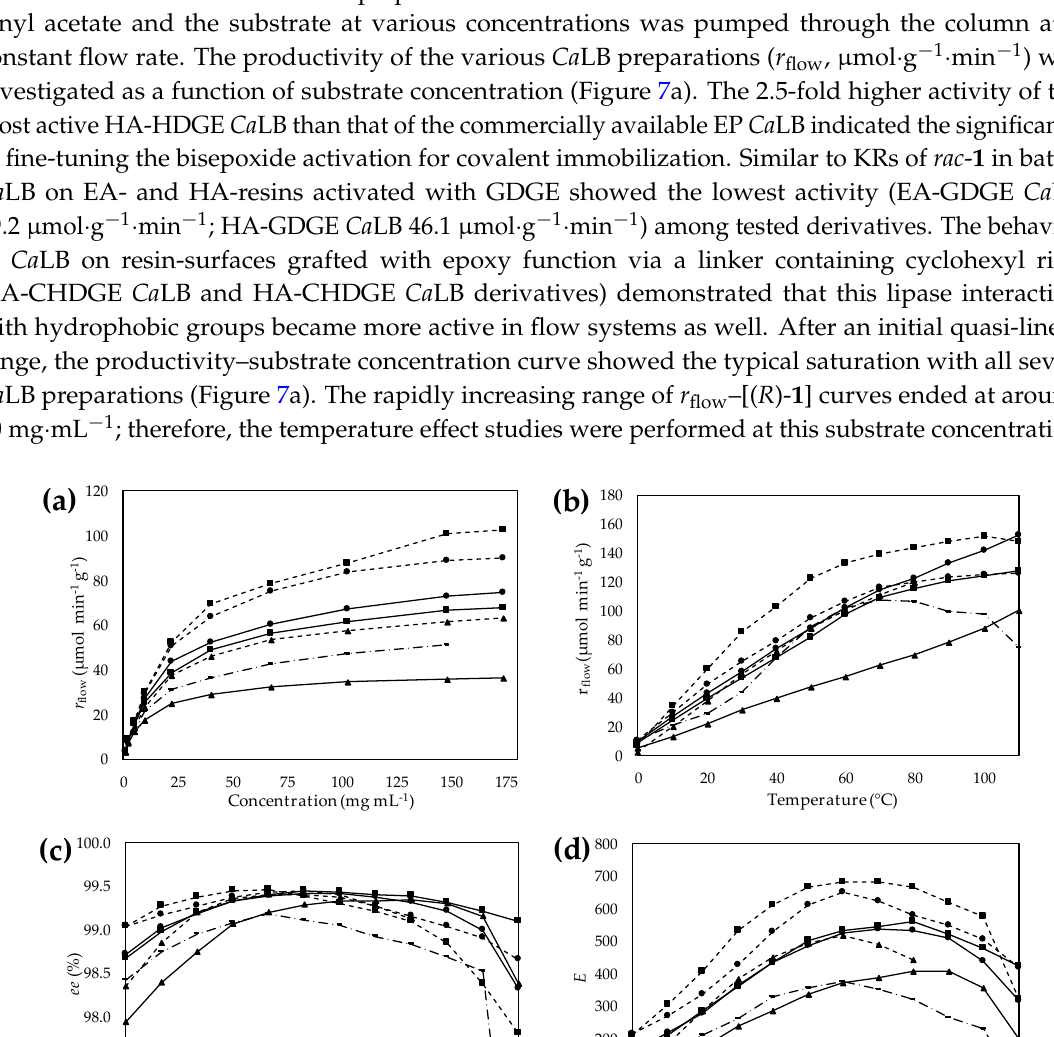
Molecules 2016 , 21 , 767 9 of 18 2.6. Continuous-Flow Kinetic Resolution of Racemic 1-Phenylethanol (rac- 1 ) Catalyzed by CaLB Preparations on Bisepoxide-Activated Resins—Substrate Concentration and Temperature Effects Immobilization of enzymes and retention of biocatalysts played a major role in development of continuous-flow processes [42,45–47,55,56]. It was previously shown that the mode of immobilization [46] and operation temperature [45,50] could significantly influence KR processes in continuous-flow bioreactors. Therefore, six different Ca LB preparations from this study were selected to investigate